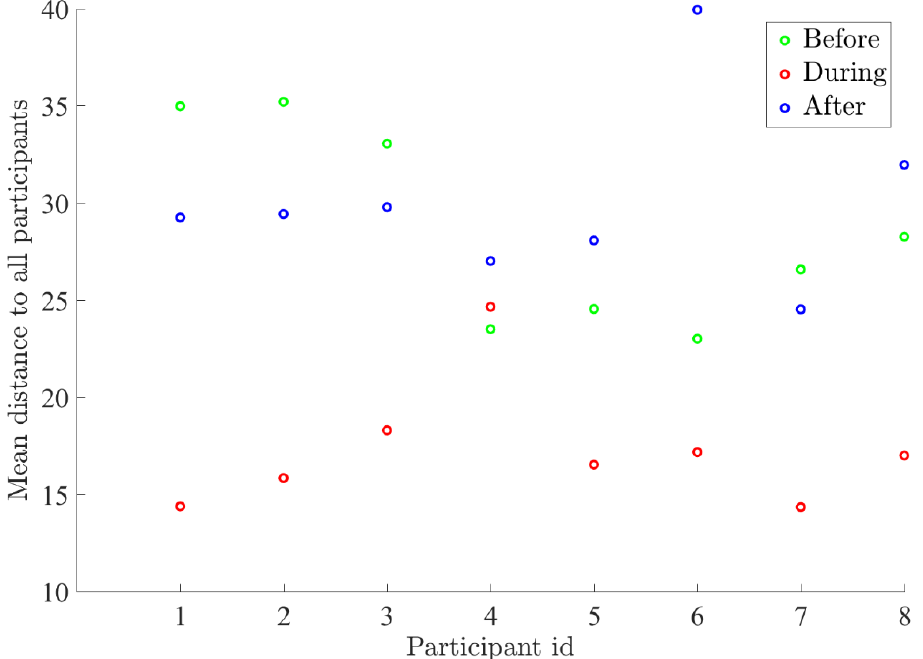
Figure A8. Pairwise synchronization for United Kingdom’s group. For the majority of participants (7 out of 8) the mean Euclidean distance during the HLI was smaller than before the HLI, indicating that the participants were more coherent with the group during the HLI than they were before it. The mean distance after the Heart Lock-In procedure is smaller than before the Heart Lock-In for four out of the eight participants.